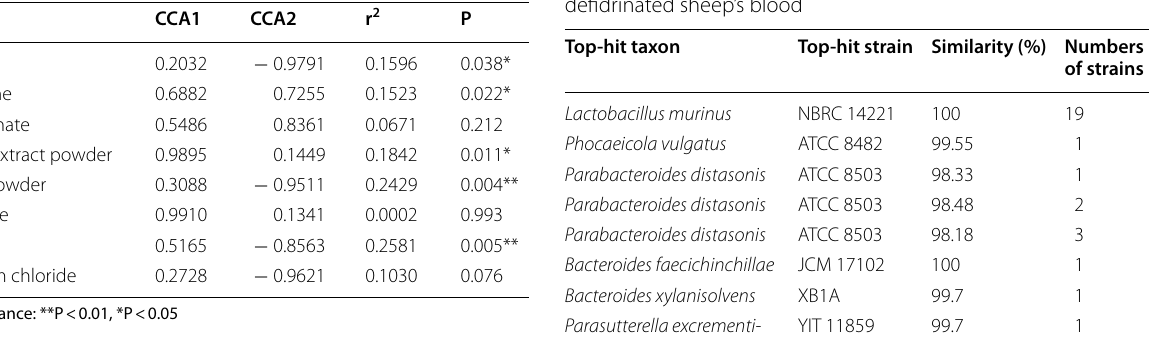
Table 2 Permutation test of Canonical correspondence analysis